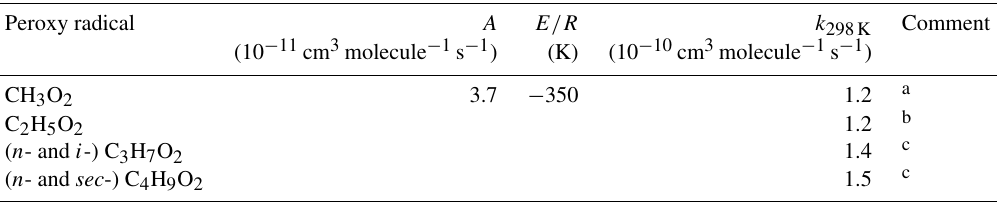
Table 6. Kinetic data for the reactions of peroxy radicals with OH. Where available, the temperature dependence is given by k = A exp ( − E/RT ) .